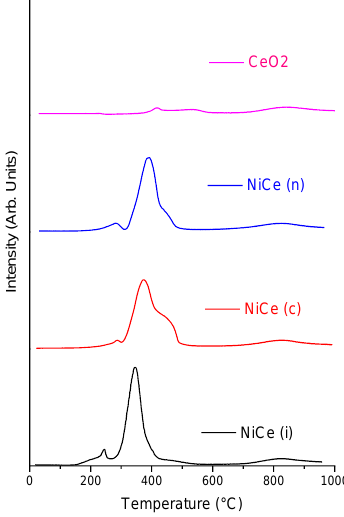
Figure 2. TPR profiles of the catalysts and pure CeO 2 as reference.